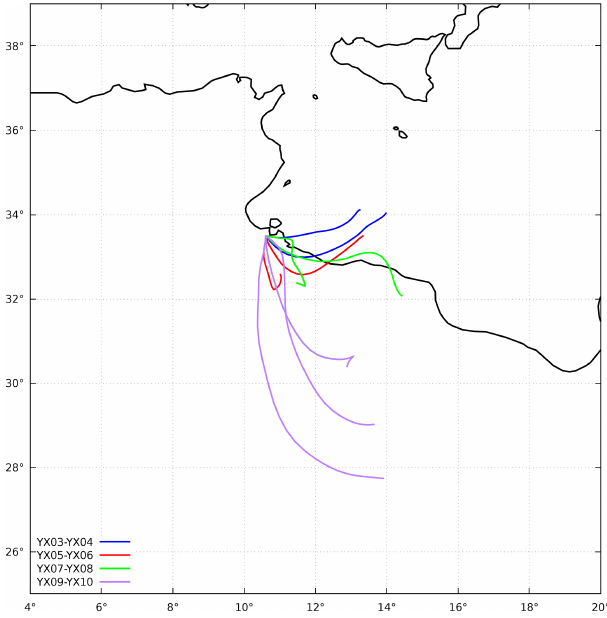
Figure C2. Backward trajectories of sample pairs YX03–YX04, YX05–YX06, YX07–YX08, and YX09–YX10. The x axis is lon- gitude, and the y axis is latitude. Two or three trajectories are asso- ciated with a given sample pair of ≈ 12h duration.